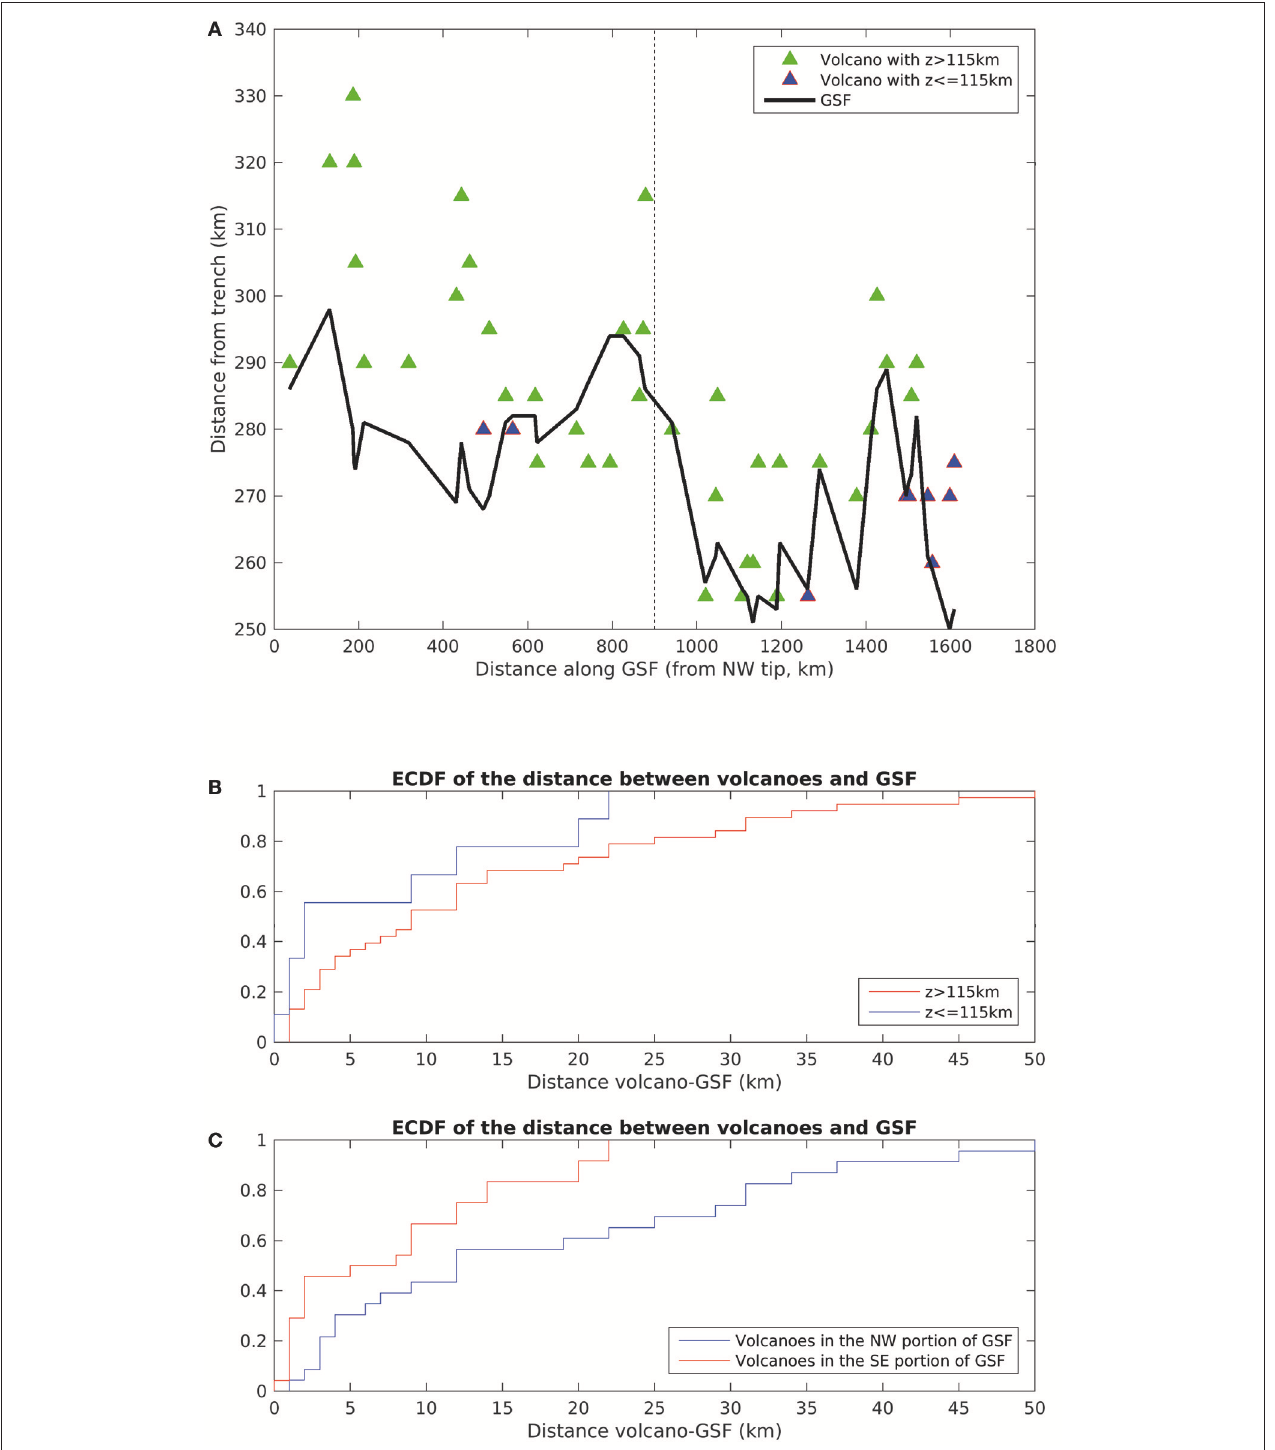
FIGURE 4 | (A) Distance of the GSF (black line) and of the Sumatran volcanoes (green triangles), also characterized by a shallower depth z of the slab (in blue), from the trench; the dashed vertical line divides the NW portion of the island from the SE portion. (B) ECDF of the distance between the volcanoes and the GSF, considering the depth of the slab z ( z > 115km and z ≤ 115km); (C) ECDF of the distance between the volcanoes and the GSF, considering the location of the volcanoes (NW or SE portion of Sumatra). See text for details.